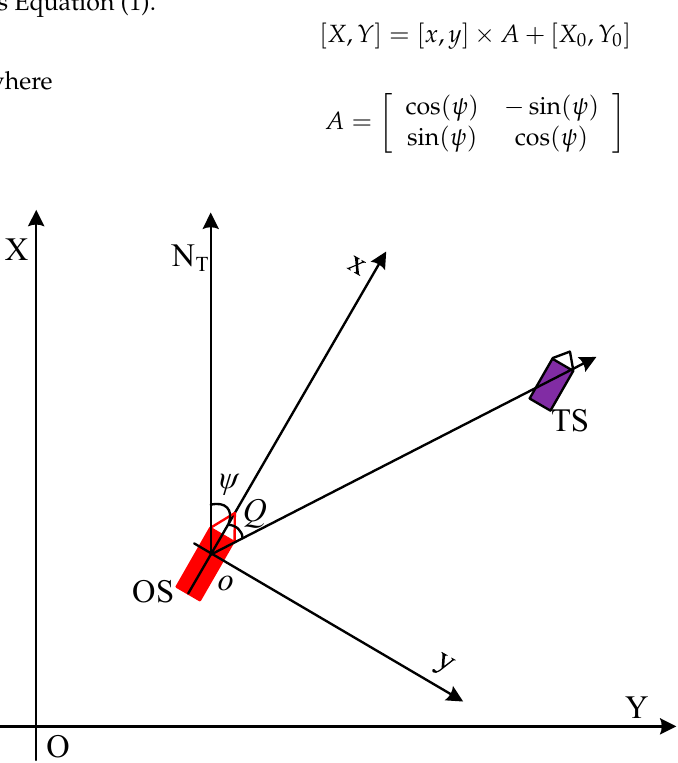
Figure 2. Two-coordinate systems. XOY is the fixed coordinate system and xoy is the ship coordinate system. ψ and Q represent the true course of the OS and relative bearing from the TS.